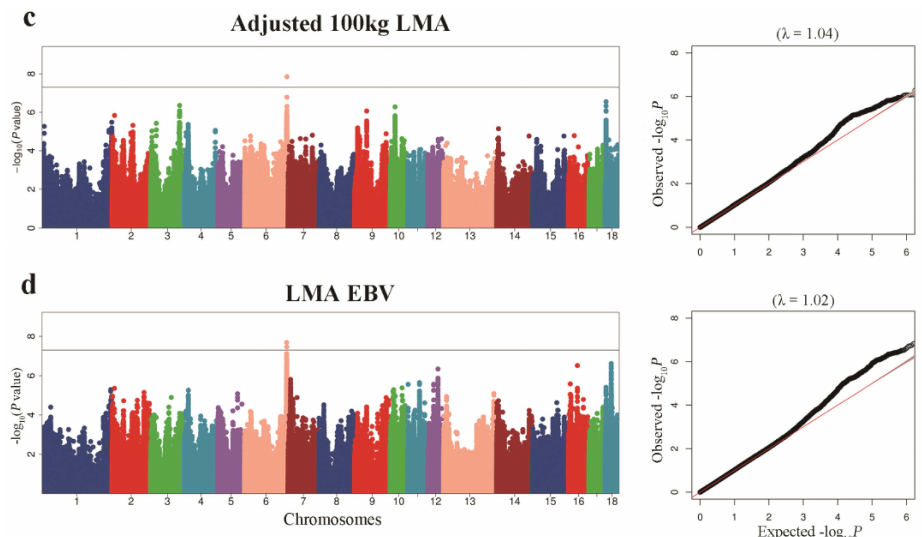
Figure 2. Manhattan plots of GWAS for BF and LMA traits in pigs. In the Manhattan plot, the solid rep- resent a significance threshold of 5 × 10 − 8 . Manhattan plot and QQ plot for: ( a ) adjusted 100 kg BF,